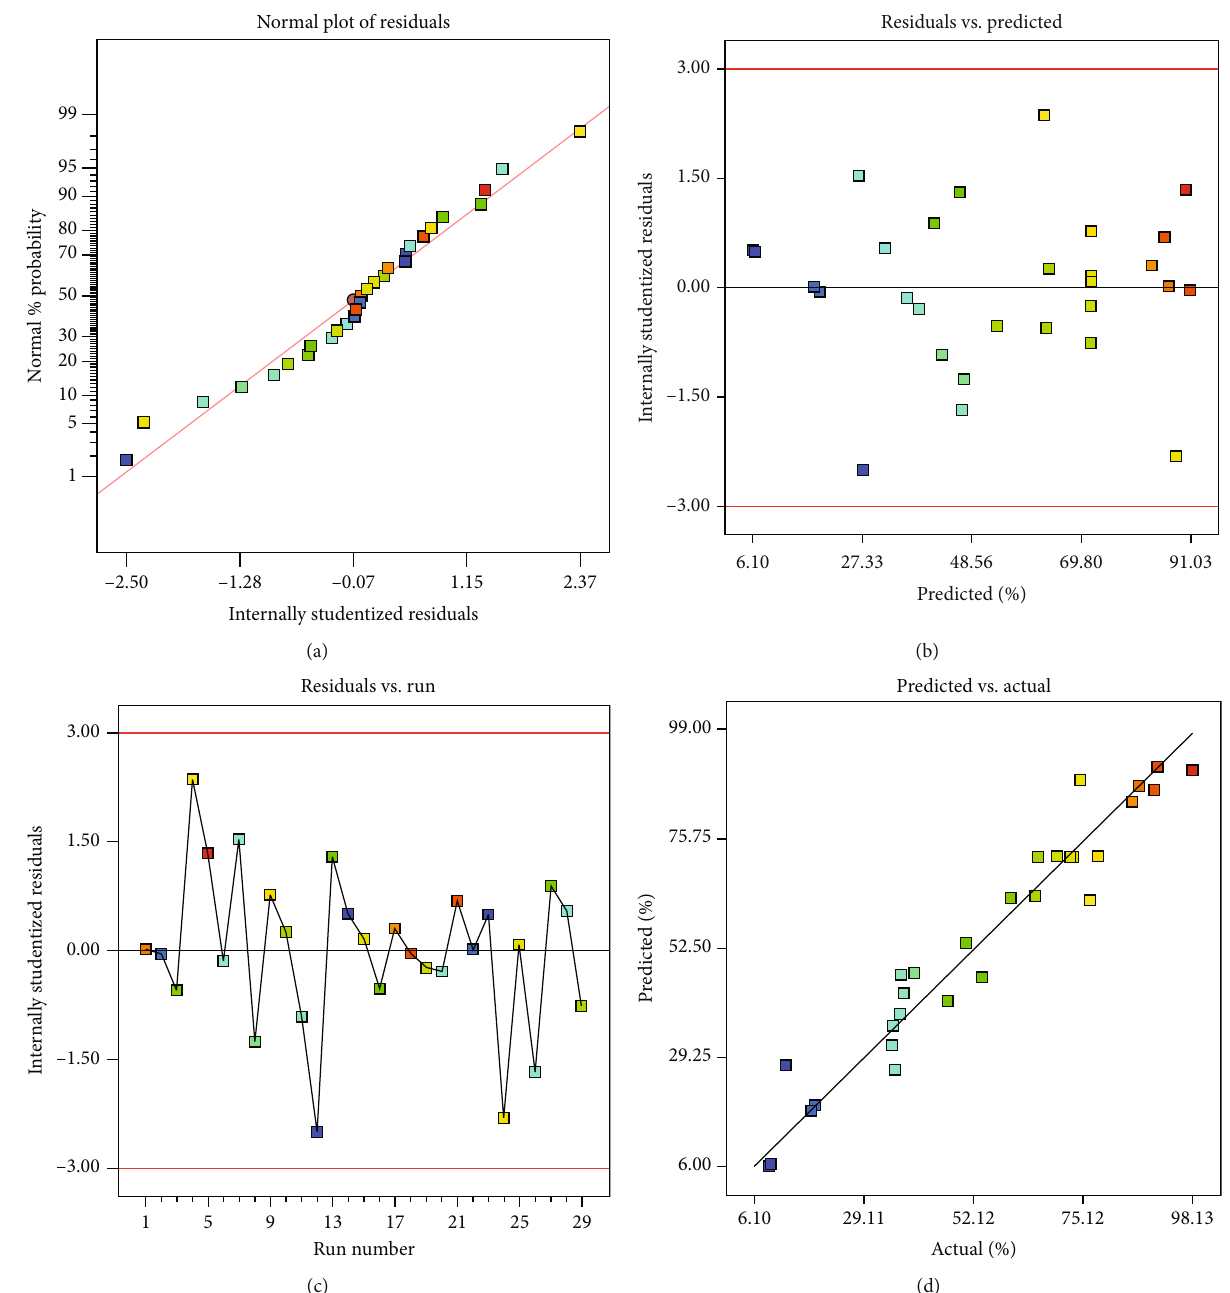
Figure 6: Residual plots for 2,4-DCP removal e ffi ciency by NZVI-rGO. (a) Residuals ’ normal possibility diagram. (b) Diagram of the residuals based on the predicted value. (c) Chronological diagram of the residuals. (d) Scatter plot of the predicted and actual